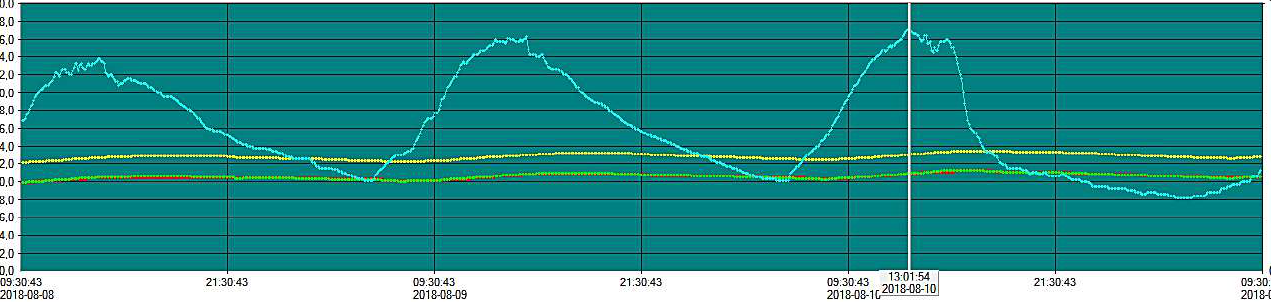
Figure 5. Example of indoor parameters: summer 8–10 August 2018; indoor temperature, +23.0 °C (line yellow); outdoor temperature, 37.0 °C (line blue). Yellow line indicates high stability of indoor temperature.